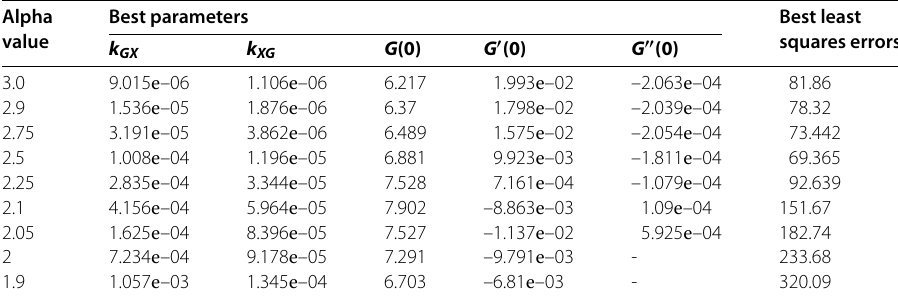
Table 1 Best least squares fits for fractional alpha model for subject 1 CGM data Alpha value